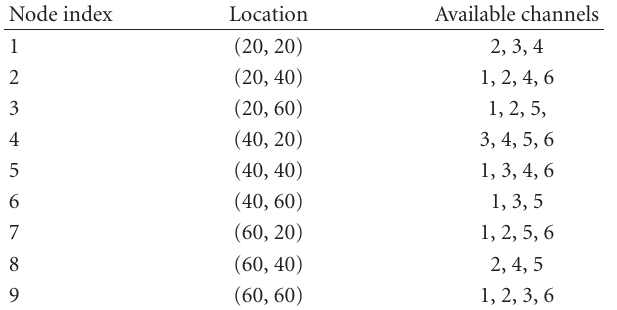
Table 3: Set of available channels at each node (i.e., C i ) for random